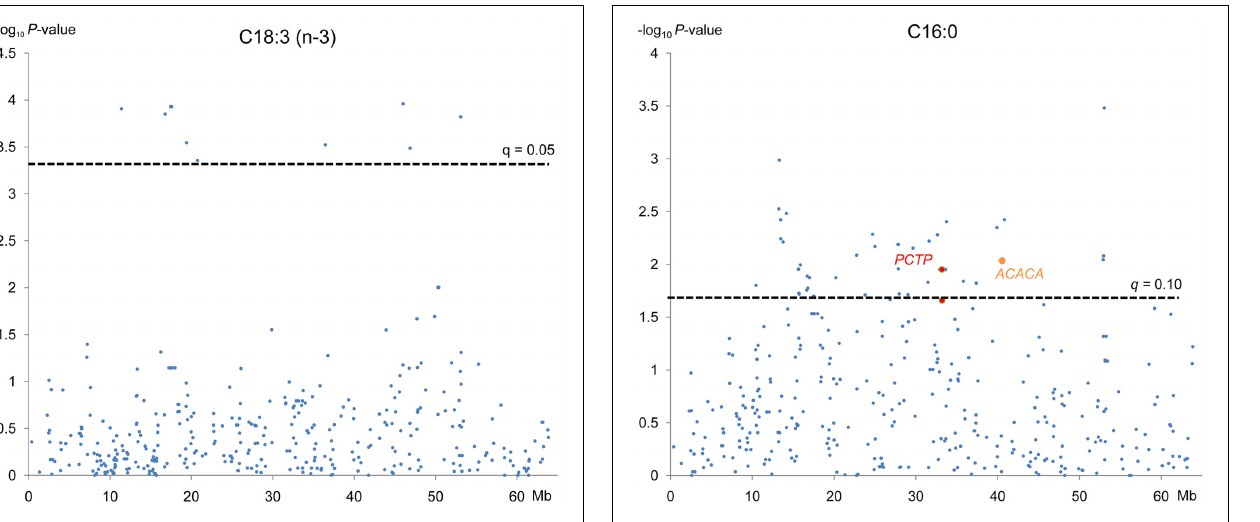
FIGURE 2 |Association analyses between C18:3 fatty acid and 374 SNPs mapped in SSC12. Each dot represents one SNP. On the y -axis are − log 10 of P -values and on the x -axis, the physical position of the SNP in the SSC12. Cut off value is 3.3 which represents a q = 0.10.